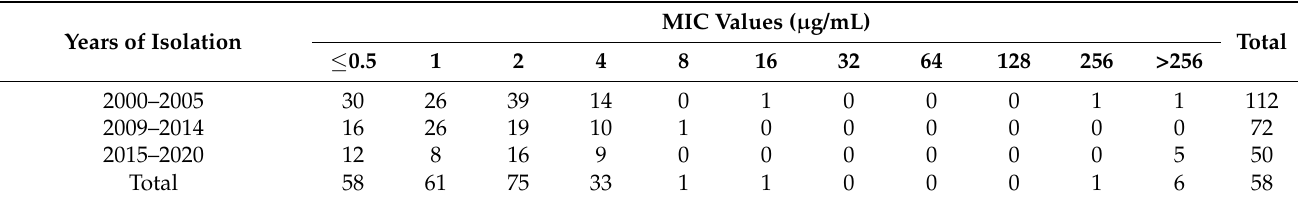
Table 1. Distribution of the tested Salmonella strains in relation to minimum inhibitory concentration (MIC) values and years of isolation.